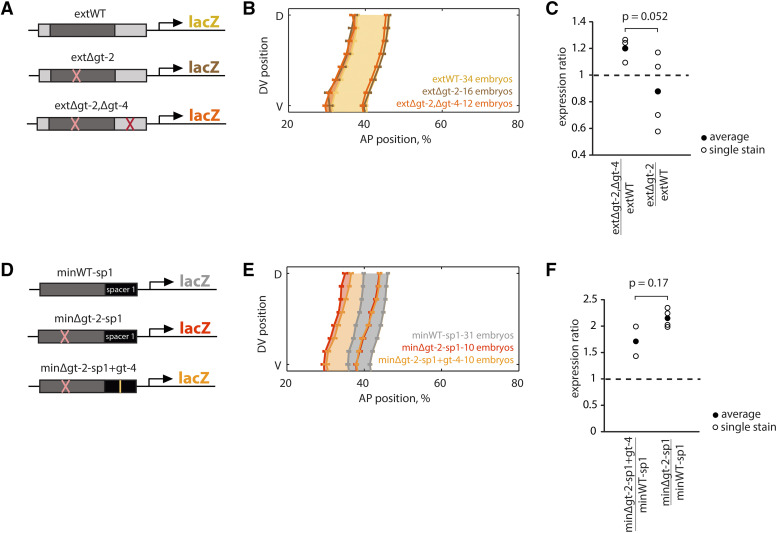
An additional Gt binding site partially explains the buffering. (A) We found an additional predicted Gt binding site outside the minimal enhancer sequence but within the extended enhancer, which we called gt-4. A reporter construct, extΔgt-2,Δgt-4, testing for the necessity of the additional Gt binding site was made by mutating the predicted gt-4 binding site. (B) The average position of the lacZ anterior boundaries was nearly identical for the extΔgt-2 and extΔgt-2,Δgt-4 constructs, indicating that eliminating the additional gt-4 binding site does not affect buffering of the gt-2 deletion on expression pattern. Error bars show standard error of the mean boundary positions of the expression pattern. (C) If the additional gt-4 site was necessary and sufficient for the buffering, the extΔgt-2,Δgt-4/extWT ratio would be higher than 1 and very similar to minΔgt-2/minWT ratio. If the additional gt-4 binding site was not necessary at all, the extΔgt-2,Δgt-4/extWT ratio would be similar to 1 and to the extΔgt-2/extWT ratio. The results suggest that the additional gt-4 site explains only some of the buffering of the gt-2 deletion on expression level (p(extΔgt-2,Δgt-4extWT=1) = 0.065, one-sample t-test; p(extΔgt-2,Δgt-4extWT<extΔgt-2extWT) = 0.052, one-sided, two-sample t-test with unequal variances). (D) We tested the sufficiency of the additional gt-4 binding site by making a construct with the minΔgt-2-sp1 element and inserting the additional gt-4 binding site in the same position relative to the promoter as in the extended enhancer (minΔgt-2-sp1+gt). (E) The additional gt-4 binding site shifts the anterior boundary of expression slightly to the posterior, when compared to the pattern driven by minΔgt-2-sp1. (F) The peak minΔgt-2-sp1+gt-4/minWT-sp1 ratio is lower, but not significantly different from the minΔgt-2-sp1/minWT-sp1 ratio, indicating that this gt-4 binding site is not sufficient to explain the buffering of expression level in the extended enhancer (p(minΔgt-2-sp1+gt-4minWT-sp1=1) = 0.23, one-sample t-test; p(minΔgt-2-sp1+gt-4minWT-sp1>minΔgt-2-sp1minWT-sp1) = 0.17, one-sided, two-sample t-test with unequal variances).